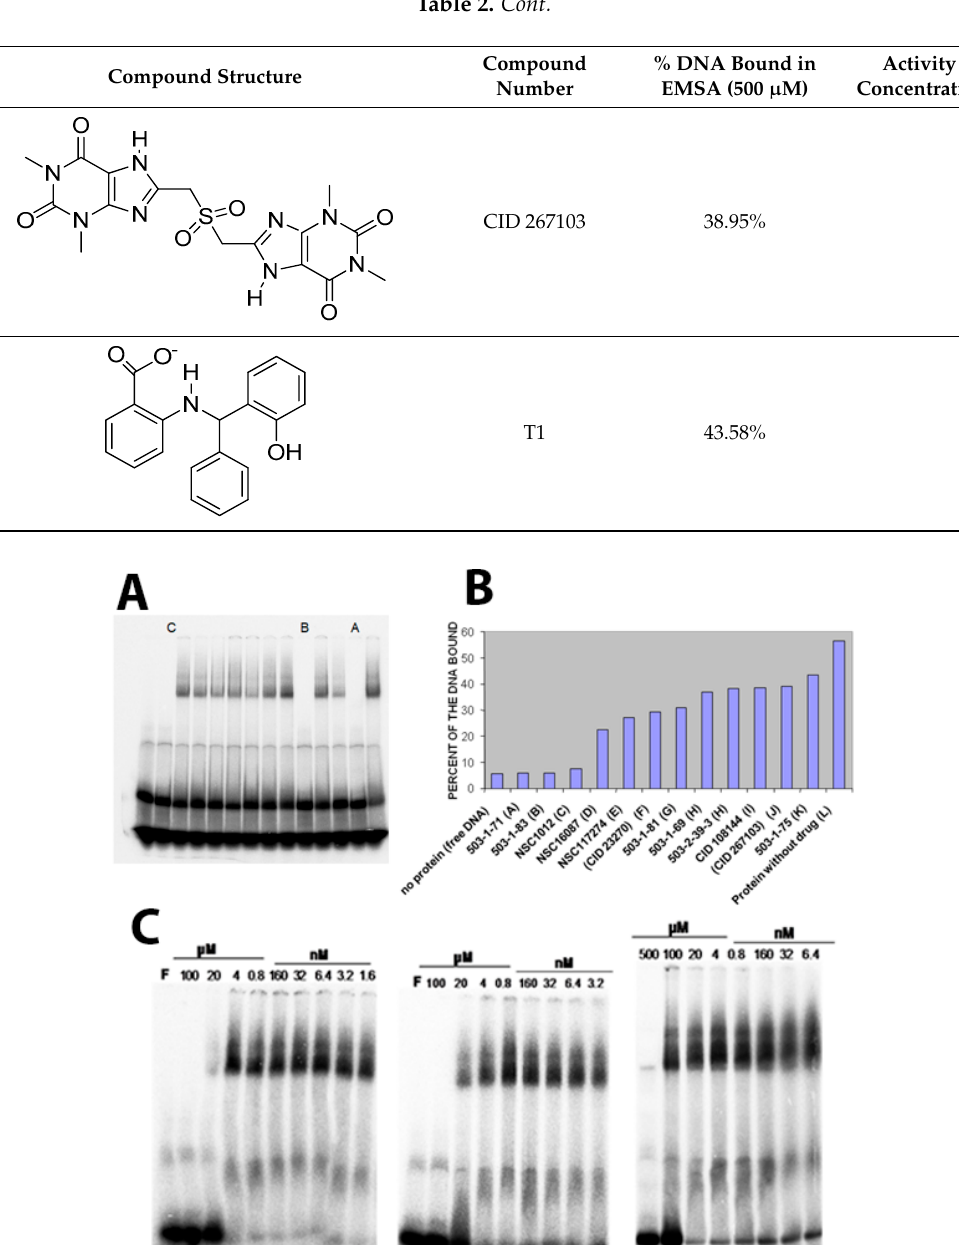
Figure 5. ( A ) EMSA showing the effect of candidate inhibitors on the DNA binding affinity of Vezf1. The protein was pre incubated 500 mM of potential inhibitors for 10 min before adding the DNA to the binding reaction. Compounds noted as A, B and C. Presence of compounds have varying effect on the DNA binding ability of VEZF1. 3 of the 12 tested compounds, A, B and C, severely affected DNA binding of the recombinant Vezf1. ( B ) The bound and free reactions were quantified and plotted as percent bound. A, B and C compounds were identified as 501-1-71, 503-1-83 and NSC1012 respectively. ( C ) To determine the minimum concentration at which these 3 drugs were effective, DNA binding assays were done by pre-incubating 640 nM Vezf1 with varying concentrations of the 3 selected inhibitors, followed by DNA binding assay. As shown, 503-1-83 was most effective in blocking DNA binding by Vezf1 at 20 μ M, whereas 503-1-71 showed similar affect at about 100 μ M and NSC1012 at 500 μ M.